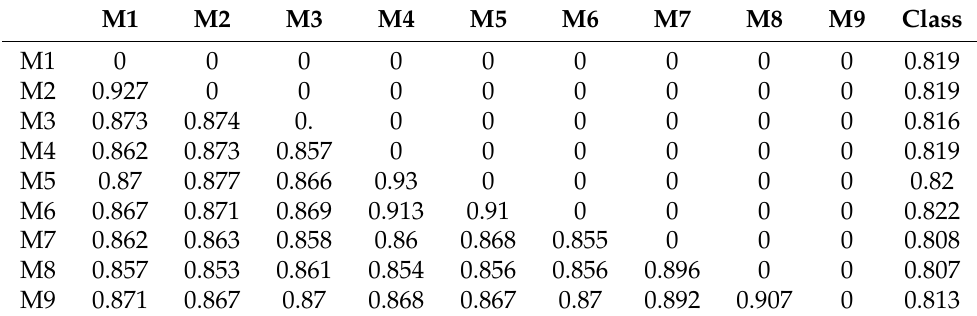
Table 6. Evaluation of model